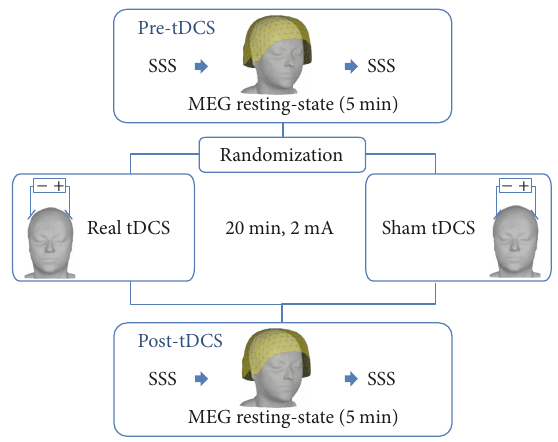
Figure 1: Experimental